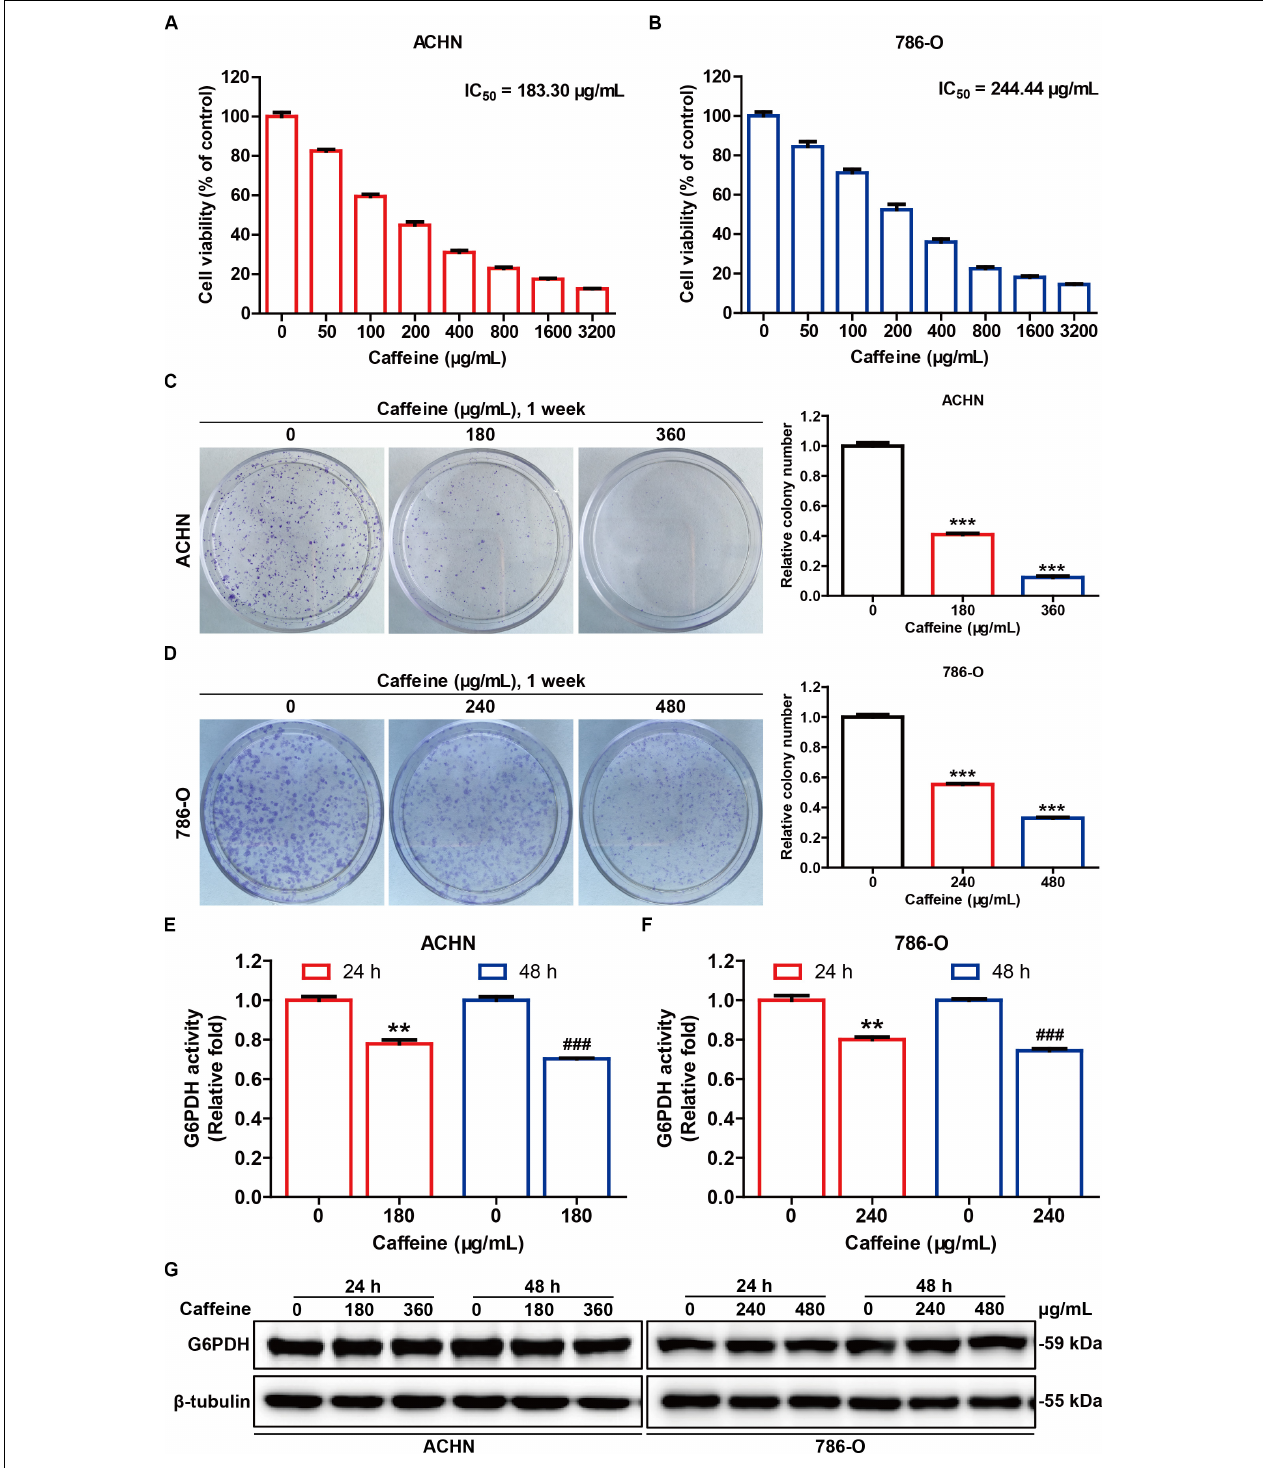
FIGURE 3 | Caffeine suppresses RCC cell proliferation and G6PDH activity in vitro . The inhibitory effect of caffeine on ACHN (A) and 786-O (B) cell growth, as measured by MTT assay. The IC 50 values were calculated at 48 h. Clonogenic survival assay of ACHN (C) and 786-O (D) cells treated with caffeine at the indicated concentrations. *** P < 0.001 versus the control group. G6PDH activity in ACHN (E) and 786-O (F) cells treated with caffeine at the indicated conditions, as measured using a G6PDH Activity Colorimetric Assay Kit. ** P < 0.01 versus the control group at 24 h; ### P < 0.001 versus the control group at 48 h. (G) The expression level of G6PDH in ACHN and 786-O cells treated with caffeine, as determined by western blotting. Representative images are displayed. Data are shown as means ± SEM of triplicated experiments.